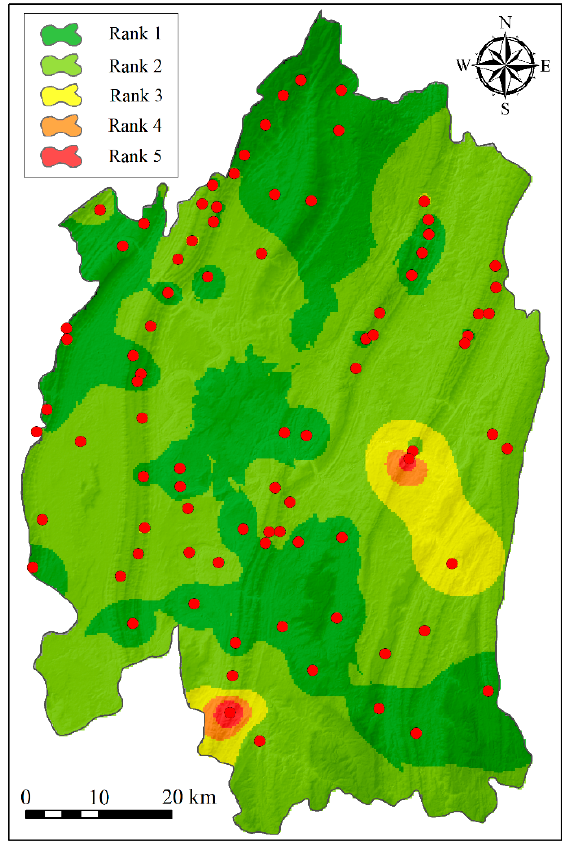
Figure 10. The spatial distribution of groundwater quality based on the EWQI rank.